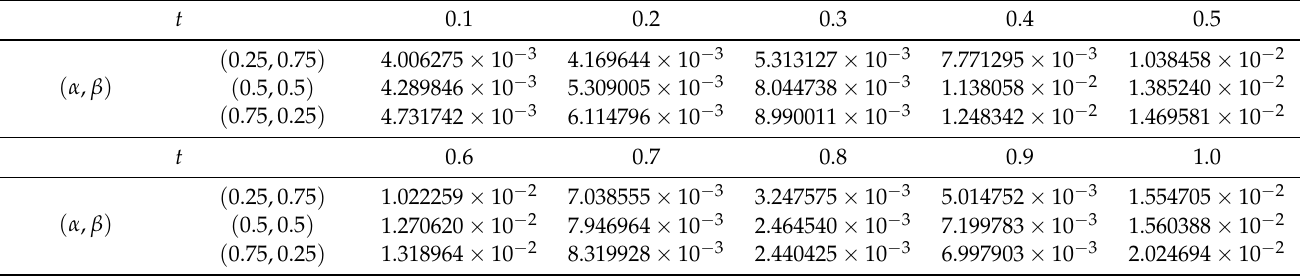
Table 1. Fractional equation of Example 1: maximum absolute error E ∞ at some time nodes, where ∆ t = 0.01, ( α , β ) is fixed to be ( 0.25,0.75 ) , ( 0.5,0.5 ) , and ( 0.75,0.25 ) in turn, and noiseless data are used.